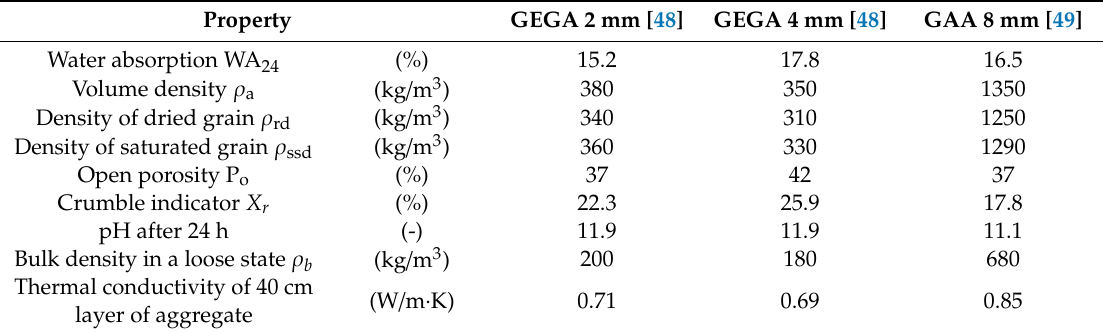
Table 3. Physical properties of the aggregates.